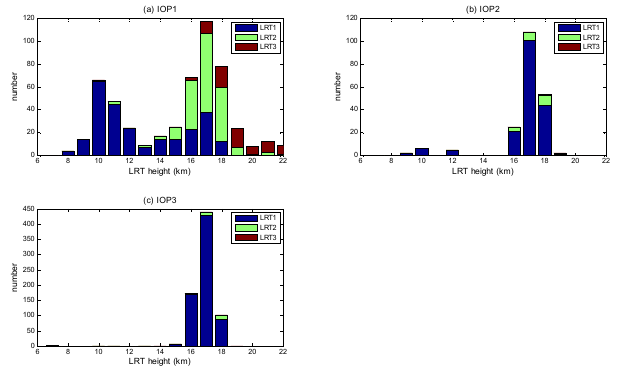
Fig. 3. Distribution of multi-tropopause heights at different phases of the monsoon. The first tropopause (LRT1), second tropopause (LRT2) and third tropopause (LRT3) are displayed by blue, green and brown color separately. Table 1 lists which sites and data are analyzed in these three IOPs.